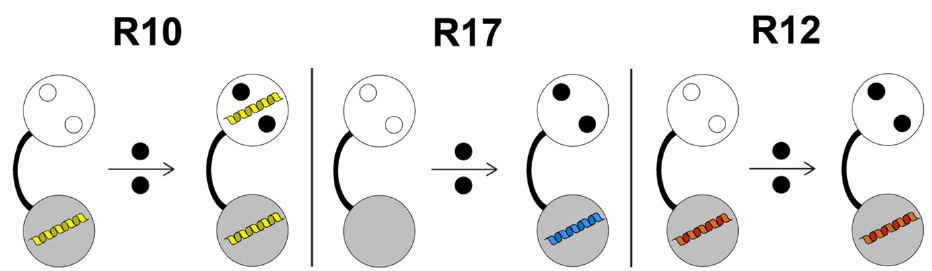
Figure 7. Schematic illustration of the binding modes of TgCEN1 with different repeats from TgSFI1. TgCEN1 is shown as a dumbbell, indicating its two-domain structure (N- and C-lobes in white and gray, respectively); open circles denote unoccupied Ca 2+ -binding sites; filled black circles are Ca 2+ ions. Yellow, blue, and red α -helices denote the representative R10, R17, and R12 target peptides, respectively. TgCEN1 exhibits two binding sites for R10 with distinct affinities: the C-lobe binds the peptide with very high affinity and poor Ca 2+ sensitivity, while the N-lobe binds R10 with moderate affinity only in the presence of Ca 2+ . TgCEN1 binds R17 with moderate affinity only via the C-lobe in a strictly Ca 2+ -dependent manner. TgCEN1 interacts with R12 through the C-terminal domain with moderate Ca 2+ sensitivity.